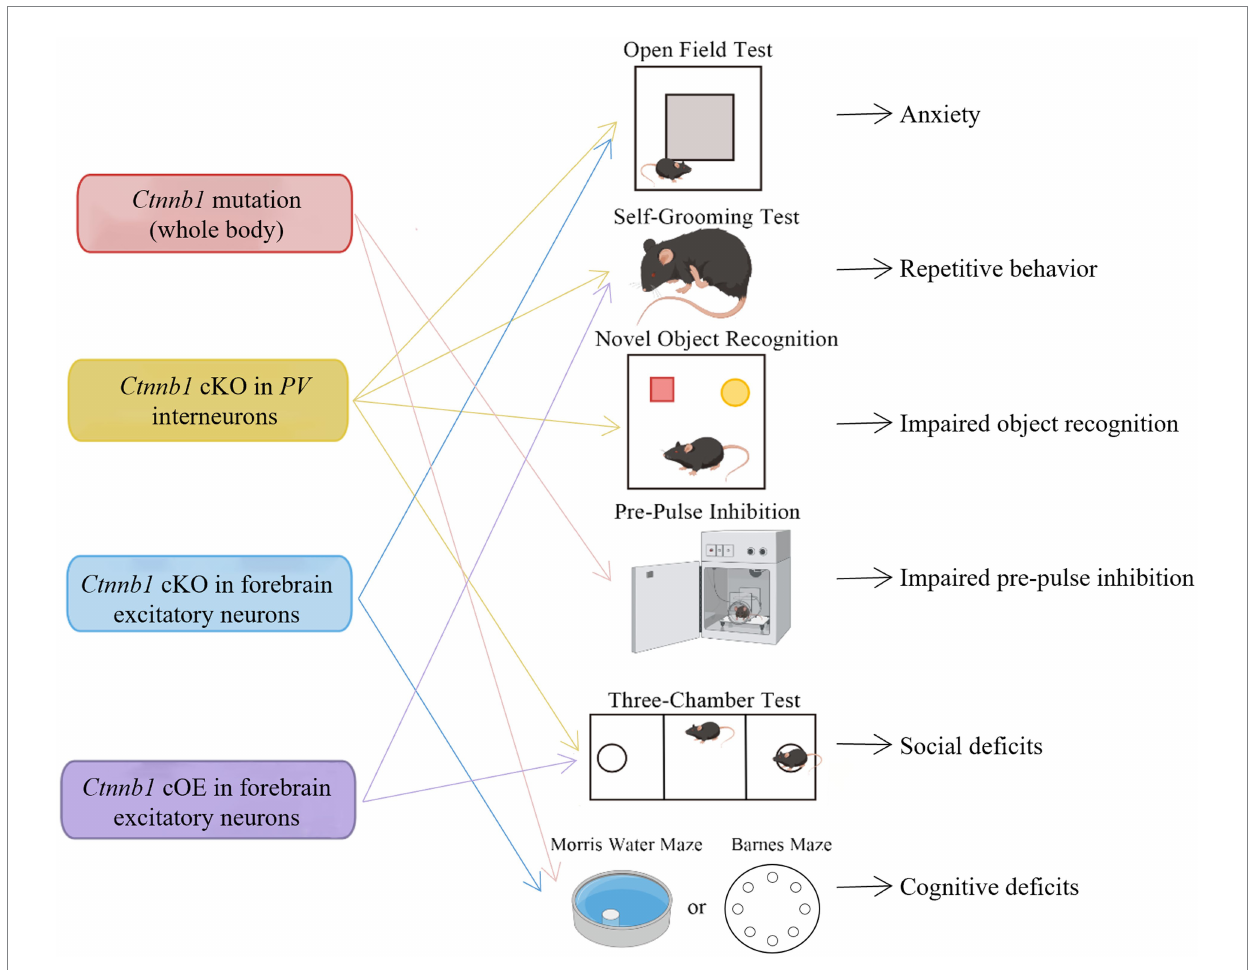
FIGURE 3 Behavioral deficits induced by Ctnnb1 loss of function or mutations in mice. Ctnnb1 conditional knockout (cKO) in parvalbumin (PV) interneurons induces anxiety, repetitive behavior, impaired object recognition, and social deficits. Ctnnb1 cKO in forebrain excitatory neurons causes repetitive behavior and cognitive impairment. Mice with whole-body Ctnnb1 mutations have impaired pre-pulse inhibition, repetitive behavior, as well as impaired social and cognition. Ctnnb1 cOE in excitatory neurons displayed repetitive behavior and social